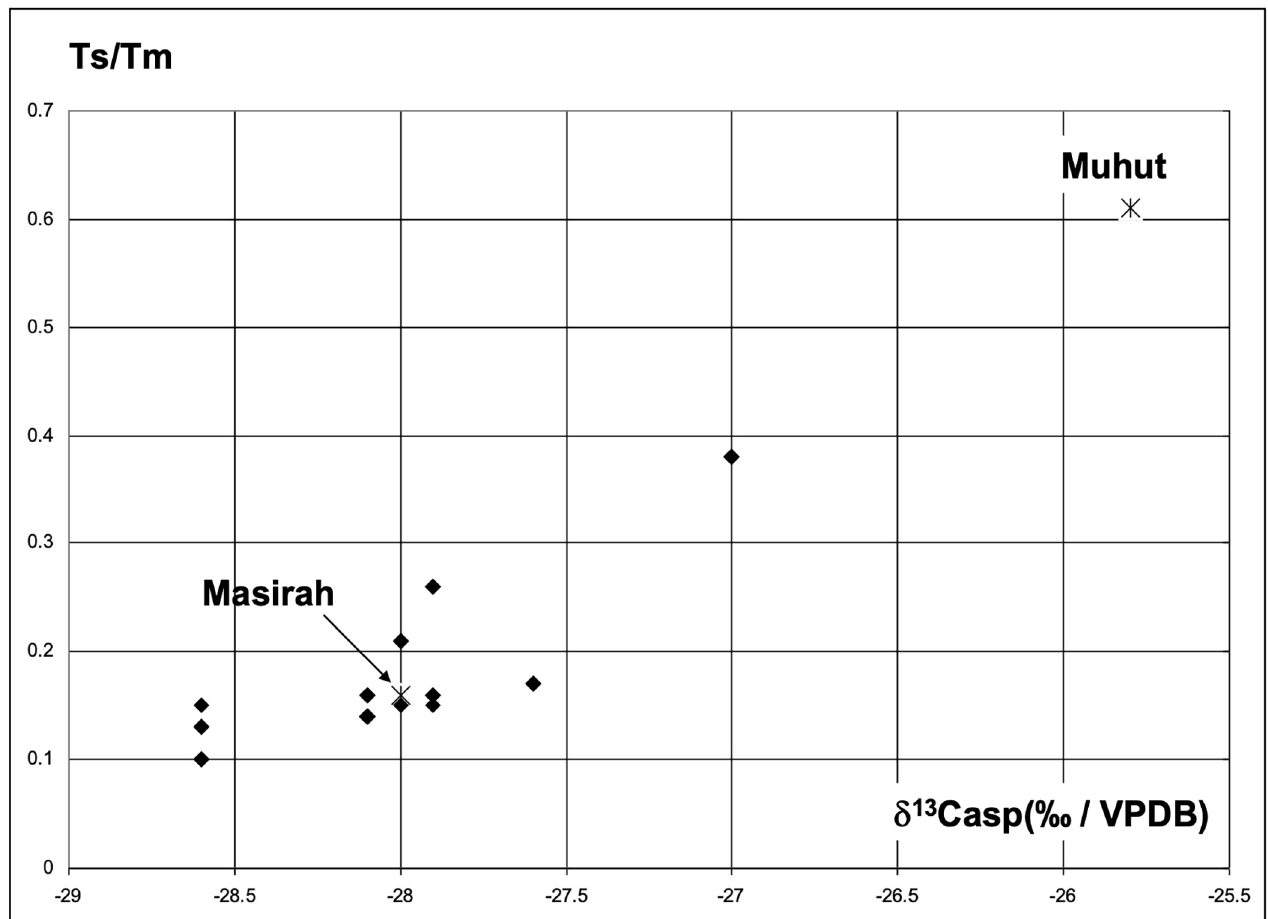
Figure 10. Mass fragmentograms of steranes ( m / z 217) and terpanes ( m / z 191) from Masirah and Muhut bitumens. Signif- icance of abbreviations: C29 αβ hopane = 17 α ,21 β -30norhopane,C30 αβ hopane = 17 α ,21 β -hopane,C31 αβ hopaneR&S = 17 α ,21 β ,22S&R-30-homohopane, C35 αβ hopaneR&S = 17 α ,21 β -22S-29pentakishomohopane, GA = gammacerane, C29 αββ R + S=5 α ,14 β ,17 β -20R + 20S-24ethylcholestane,C29 ααα R = 5 α ,14 α ,17 α -20R-24-ethylcholestane, Ts = 18 α -22,29; 30-trisnorneohopane, Tm = 17 α -22,29,30-trisnorhopane.